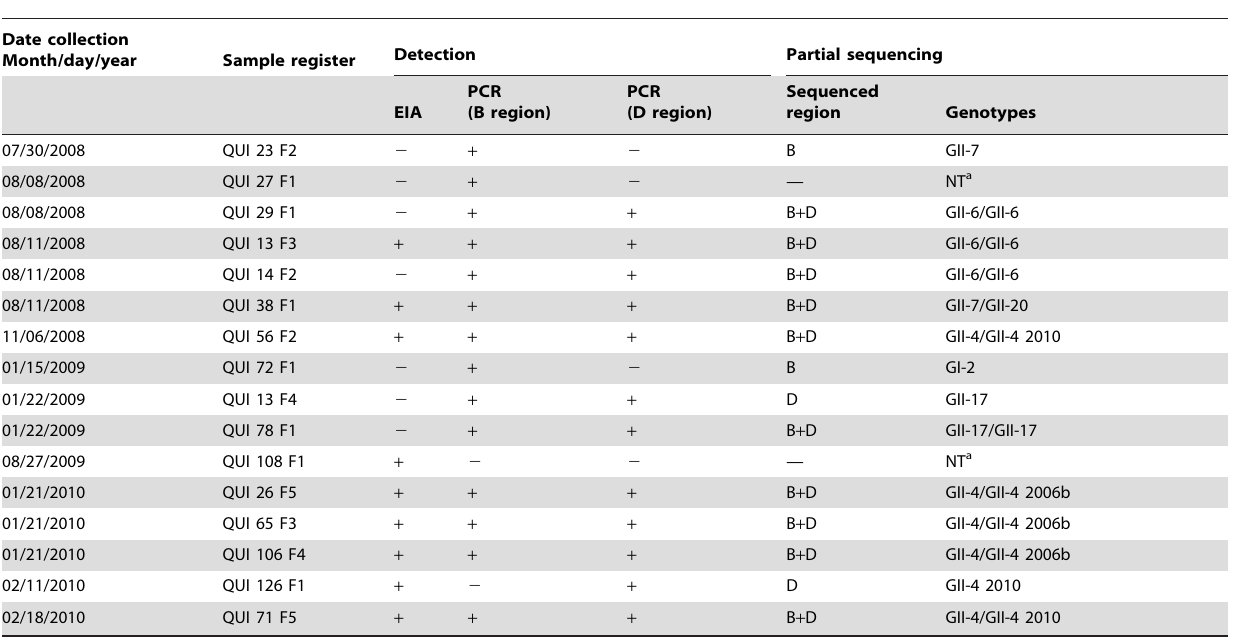
Table 1. Detection of norovirus in fecal specimens from diarrheic children from the Abacatal ‘‘Quilombola’’ Community, according to the methodology used. April/2008 to